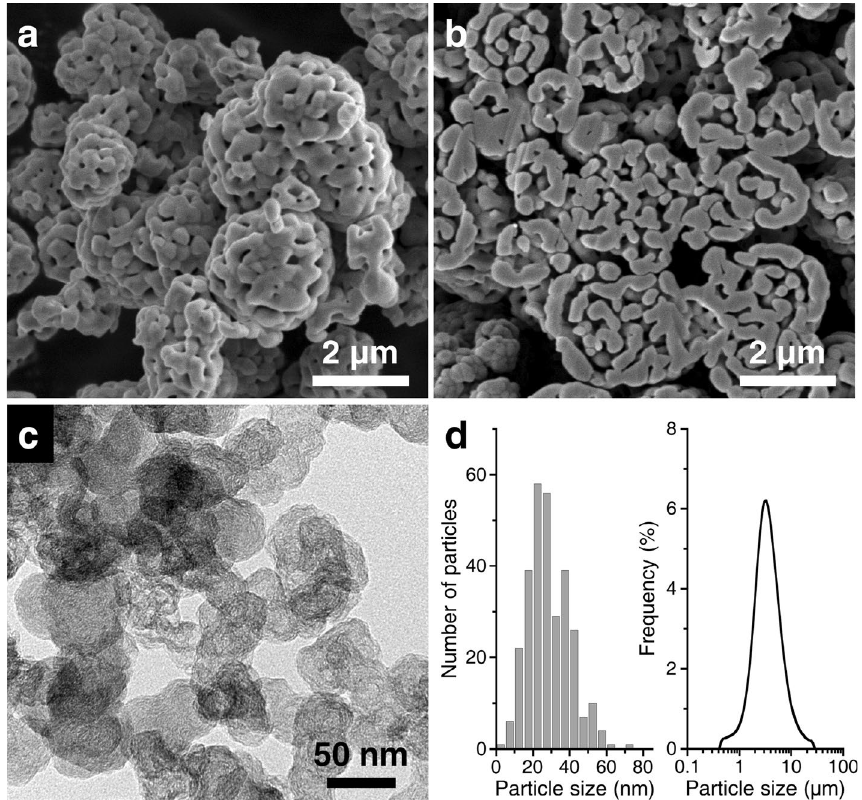
Figure 2. ( a , b ) SEM images of macroporous Mn 3 O 4 microspheres and ( c ) TEM image of carbon nanoparticles. ( d ) Particle size distributions of (left, estimated by TEM) carbon and (right, measured in a liquid) Mn 3 O 4